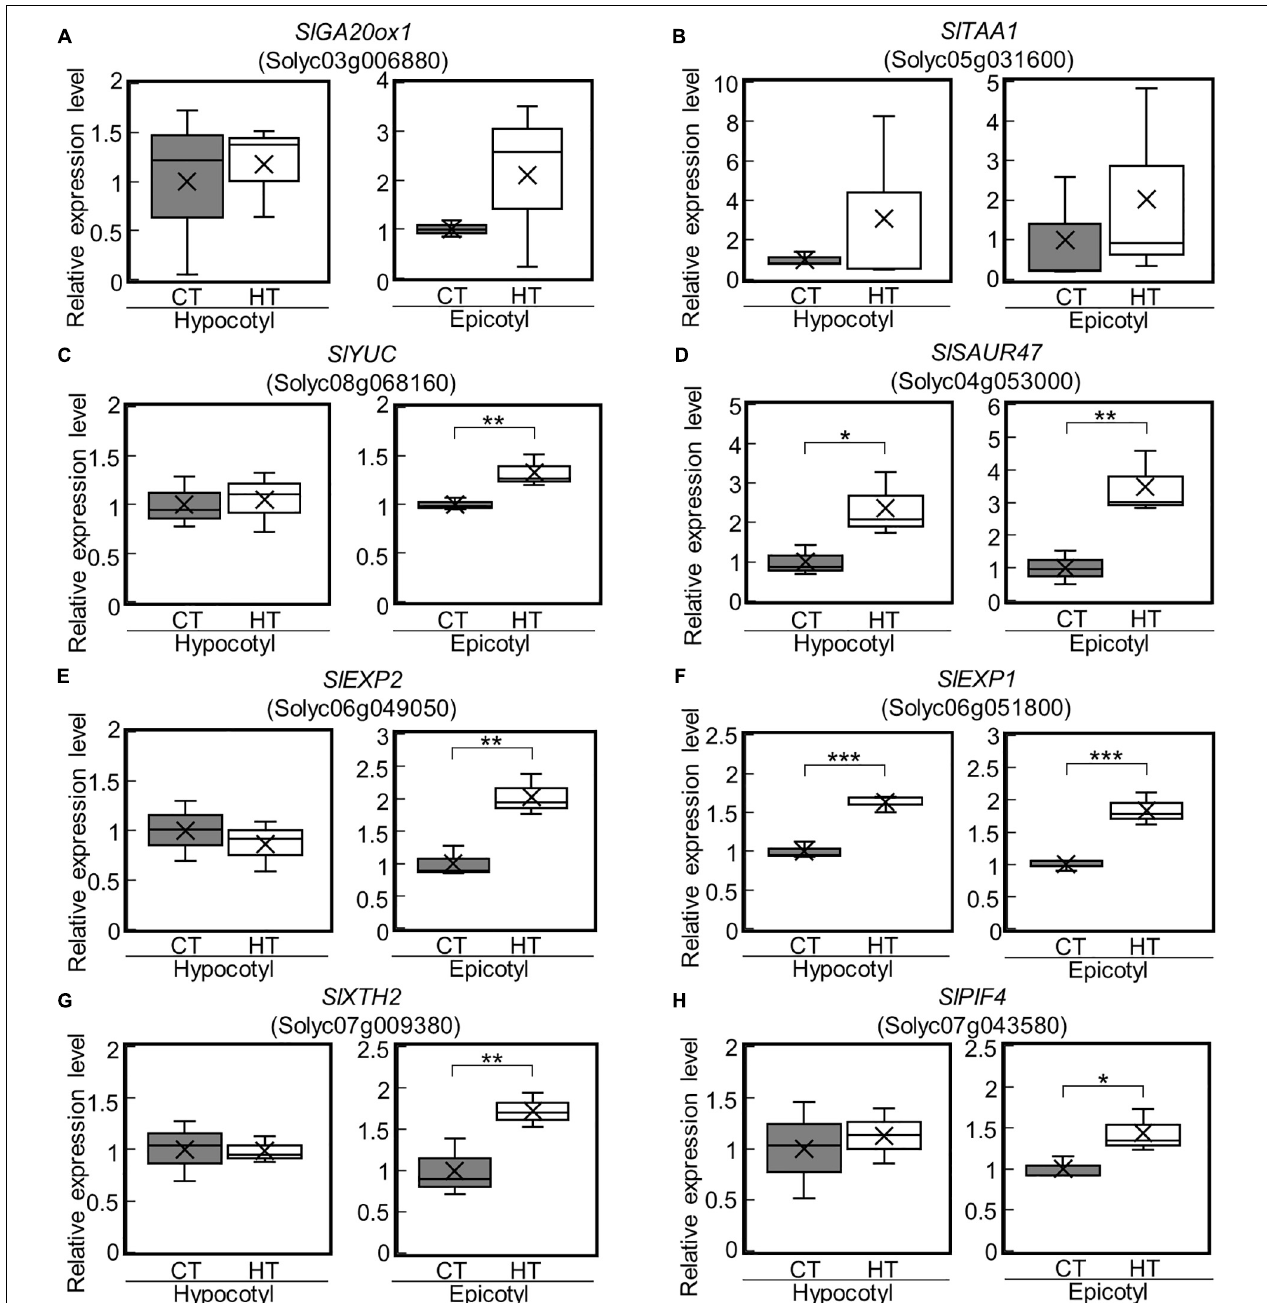
FIGURE 5 | Expression of GA-, IAA-, and cell wall-related genes in epicotyls and hypocotyls under two different temperatures. The expression of SlGA20ox1 (A) , IAA-related genes ( SlTAA1 , SlYUC , SlSAUR47 ) (B–D) , cell wall-related genes ( SlEXP2 , SlEXP1 , SlXTH2 ) (E–G) , and SlPIF4 (H) in epicotyls and hypocotyls grown under control and high temperatures were analyzed by reverse transcriptase real-time PCR. Data are shown as boxplots ( n = 3). Cross marks in boxplot indicate the mean values. * P < 0.1; ** P < 0.05; *** P < 0.01 (Student’s t test). CT, control temperature; HT, high